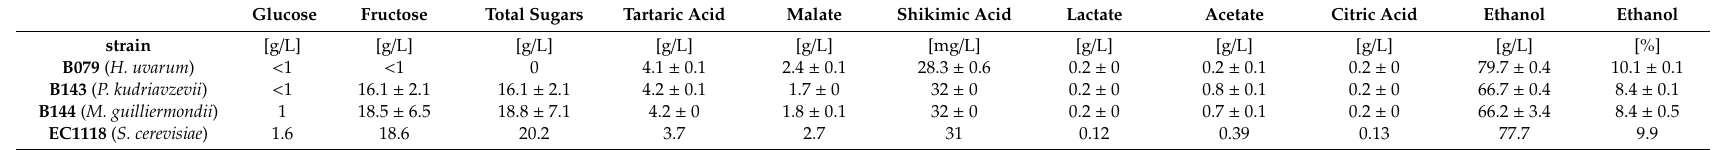
Table 1. HPLC analyses of residual sugars, organic acids and total alcohol.